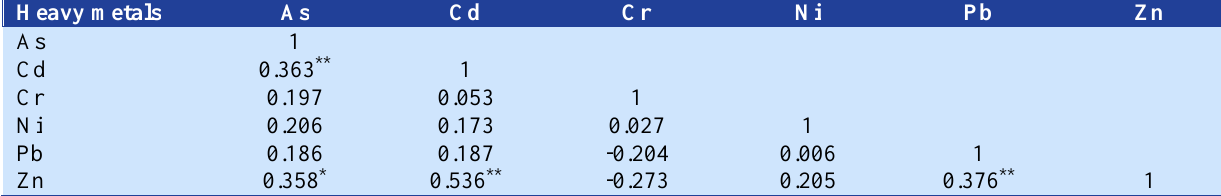
Table 4. Pearson correlation coefficients of Sanandaj roadside dust heavy metals Heavy metals